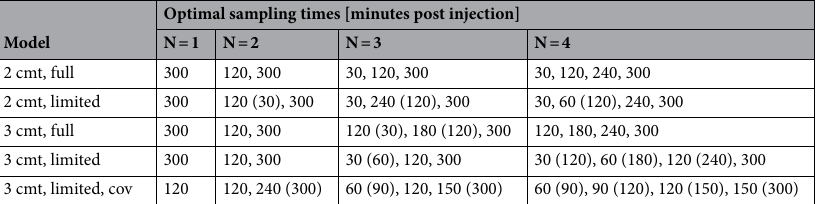
Table 2. Combinations of sampling times with N = 1 to 4 samples providing the lowest root mean squared error concerning clearance based on observed data. Brackets indicate optimal sampling times concerning predictions 1440 min post injection if they deviated from clearance-based results.